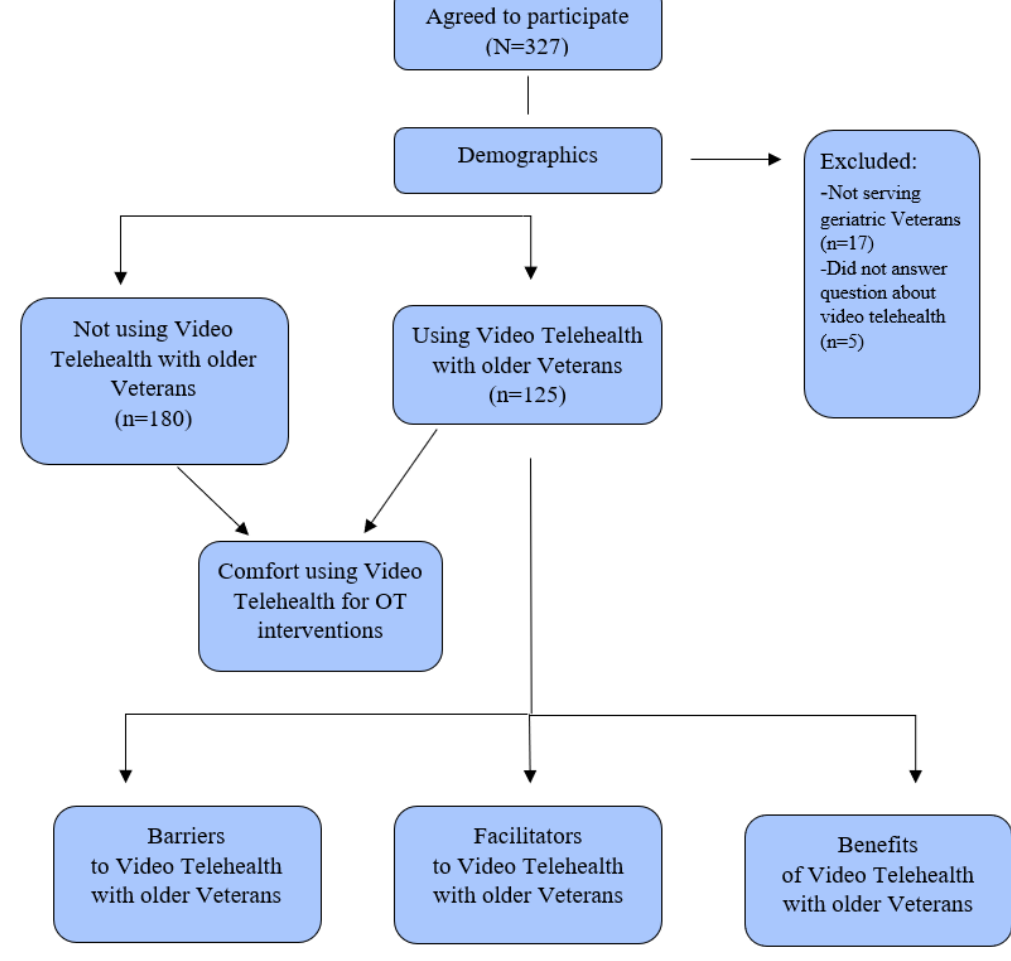
Figure 1. Survey flow diagram. OT: occupational